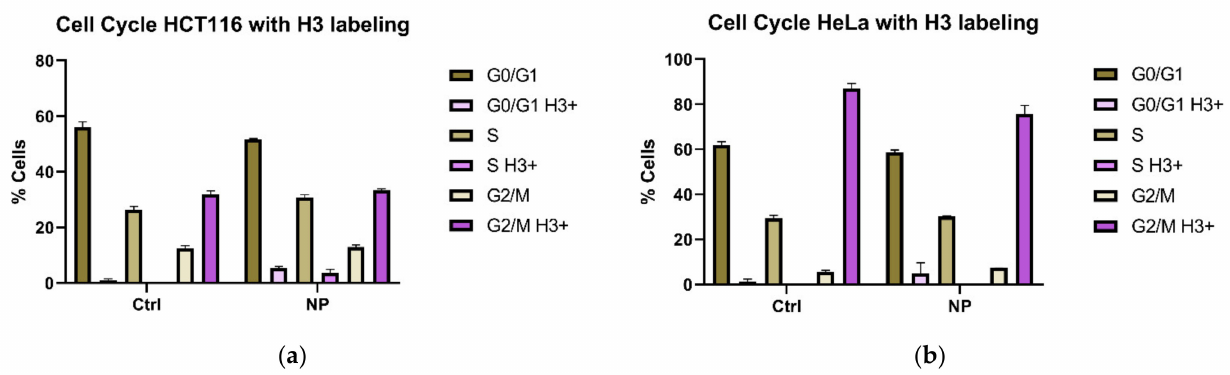
Figure 1. Cell cycle distribution of control and nanocomposite treated cells with H3 labelling. ( a ) Distribution for control and nanocomposite treated HCT116 cells. ( b ) Distribution for control and nanocomposite treated HeLa cells. Analysis for the entire population of cells ( ≥ 50,000 per biological replicate) is shown in brown color bars. Pink colored bars, as indicated in the figure legend, apply only to the population of H3 positive cells. Each bar represents the average and standard deviation from triplicate experiments; for gating strategy, see Figure S3; for cell numbers, see Table